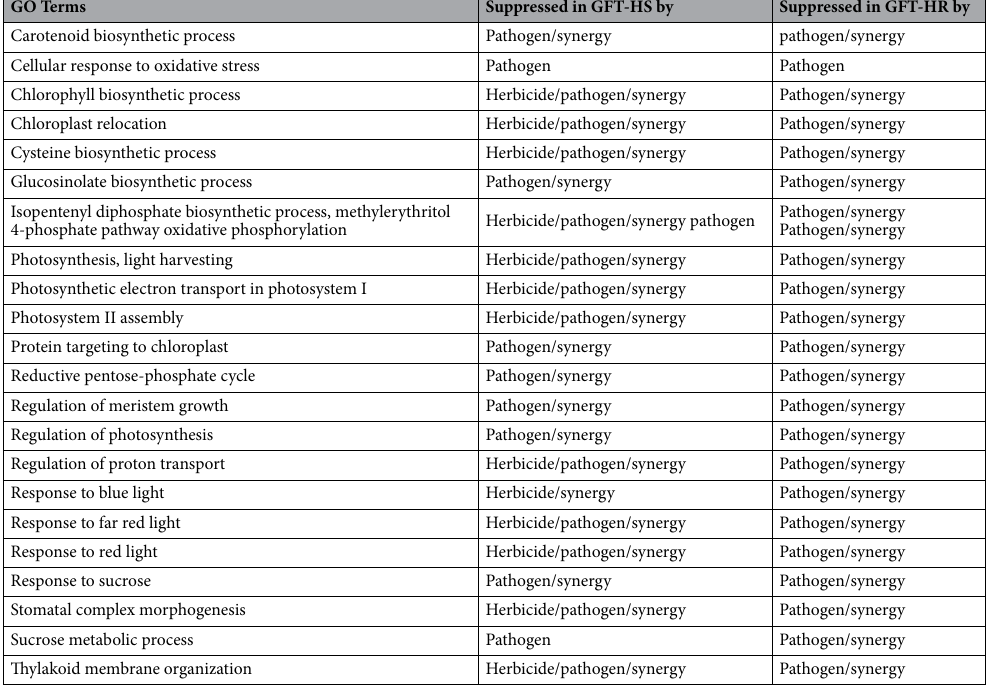
Table 5. Down-regulated biological processes in herbicide susceptible (HS) and resistant (HR) biotypes of green foxtail